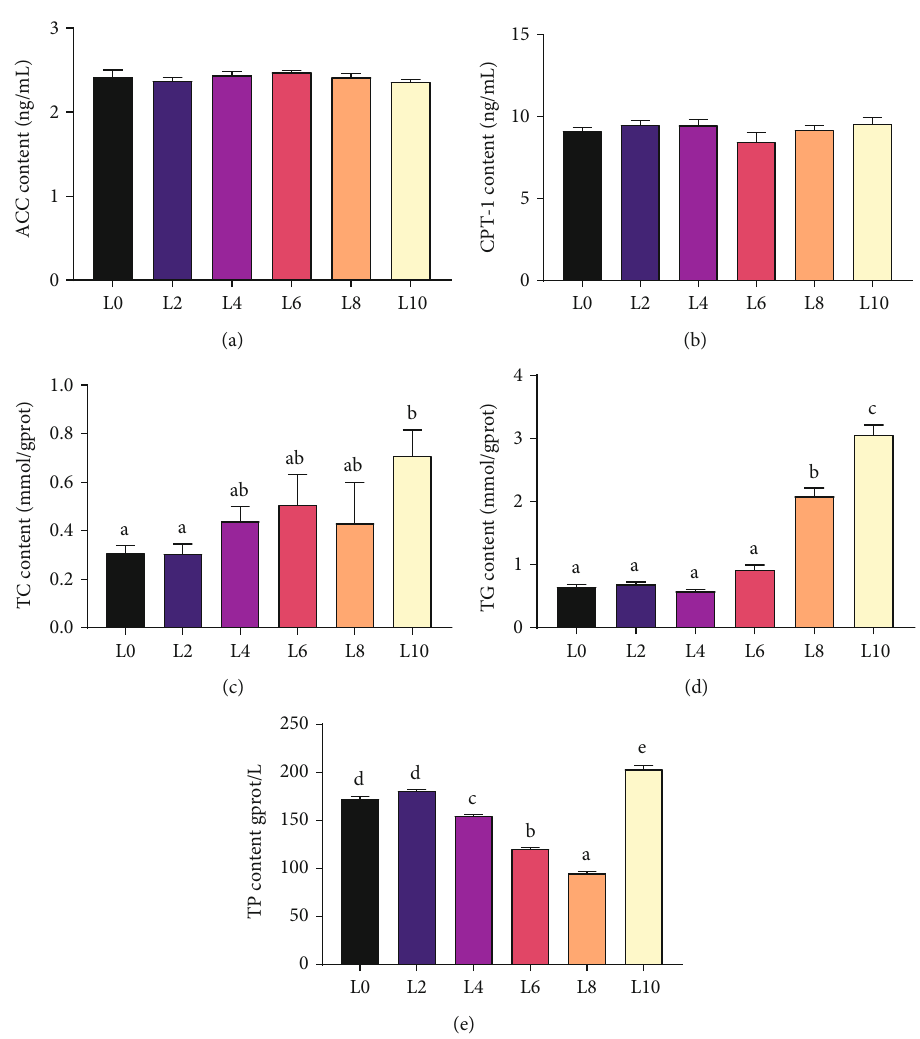
Figure 5: The contents of ACC (a), CPT-1 (b), TG (c), TC (d), and TP (e) in the hepatopancreas of C. quadricarinatus fed diets with di ff erent lipid levels. All data are expressed as the mean ± SE ( n = 6 ). Di ff erent letters indicate signi fi cant di ff erences among experimental groups ( P < 0 : 05